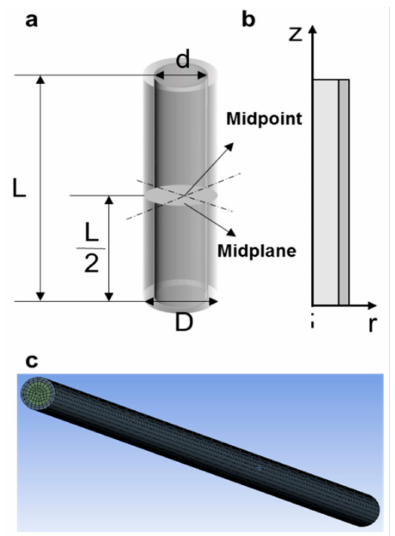
Figure 1. The straw model is used in vitrification. ( a ) A 3-D model of vitrification straw. ( b ) Bidimen- sional revolution surface. ( c ) Finite element meshes of the straw